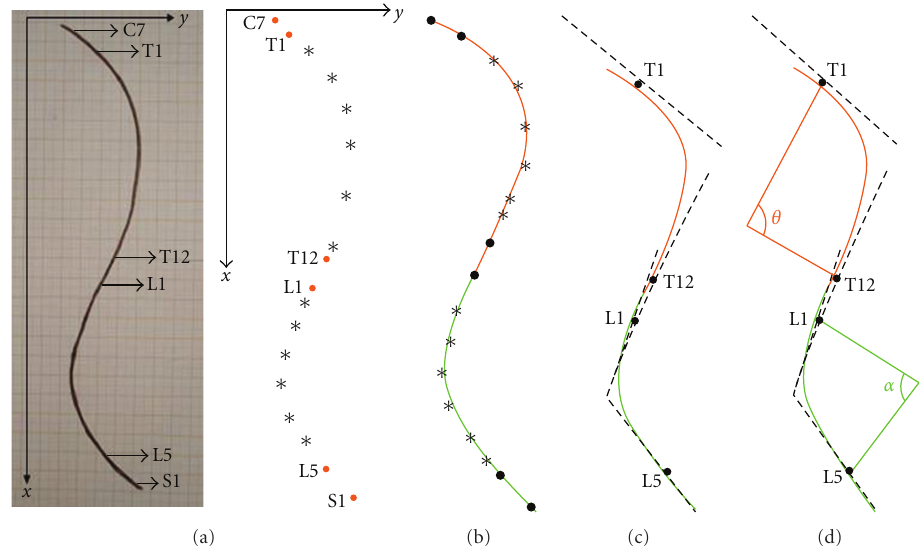
Figure 4: (a) Outline on graph paper of the spine and points representing the shape of the lumbar and thoracic curvatures; (b) drawing of the curvatures obtained using two 3rd polynomial; (c) drawing the tangents on the limit points of the curvatures (T1/T12 for thoracic, L1/L5 for lumbar); (d) drawing the straight lines perpendicular to the tangents and establishing the thoracic ( θ ) and lumbar ( α ) angles.